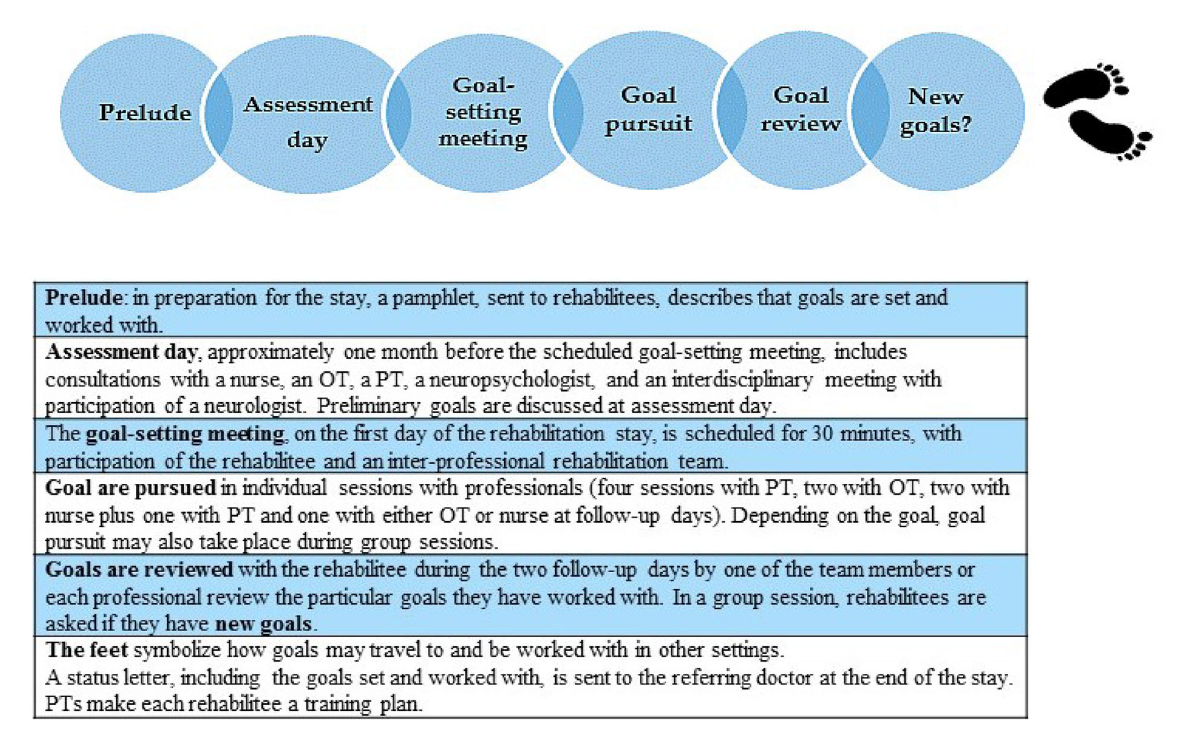
FIGURE2 Goal process at Sano rehabilitation